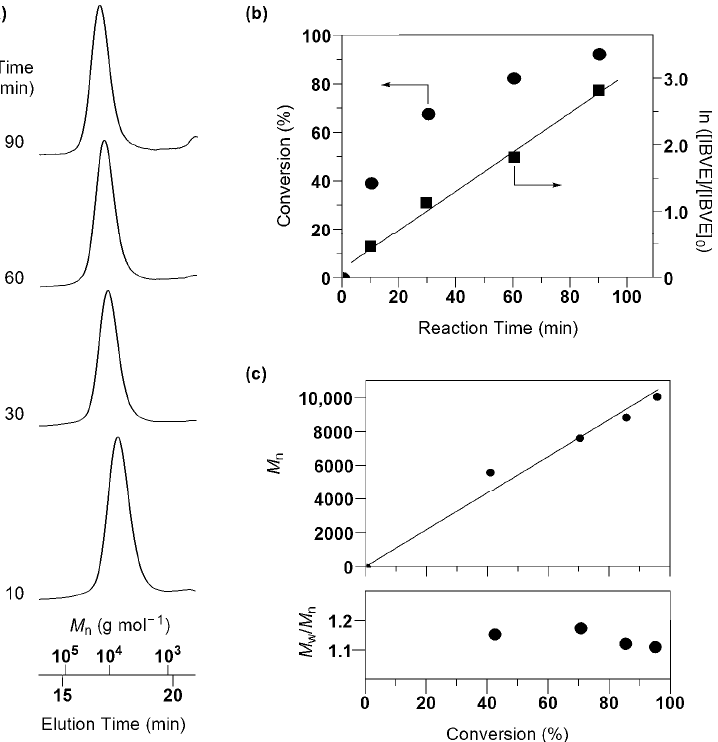
Figure 3. ( a ) SEC curves of SP-PIBVE measured in THF, ( b ) a time-conversion curve and first-order kinetic plot for the polymerization of IBVE, and ( c ) M n and M w / M n values of SP- PIBVE plotted against monomer conversion. Polymerization was conducted with SPVE-TFA/EtAlCl 2 /dioxane in toluene at 0 °C ([IBVE] 0 = 1000 mmol L − 1 , [EtAlCl 2 ] 0 = 20 mmol L − 1 , [dioxane] 0 = 900 mmol L − 1 , [SPVE-TFA] 0 = 10 mmol L − 1 ).